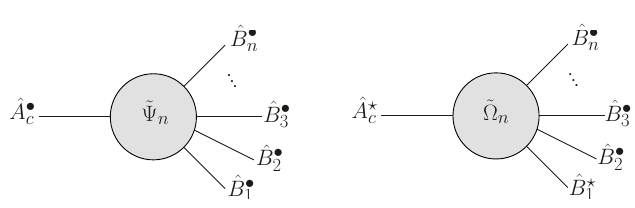
Figure 3 . Graphical representation for the currents that give the Yang-Mills field expansion into the new fields B , see eqs. (3.12),